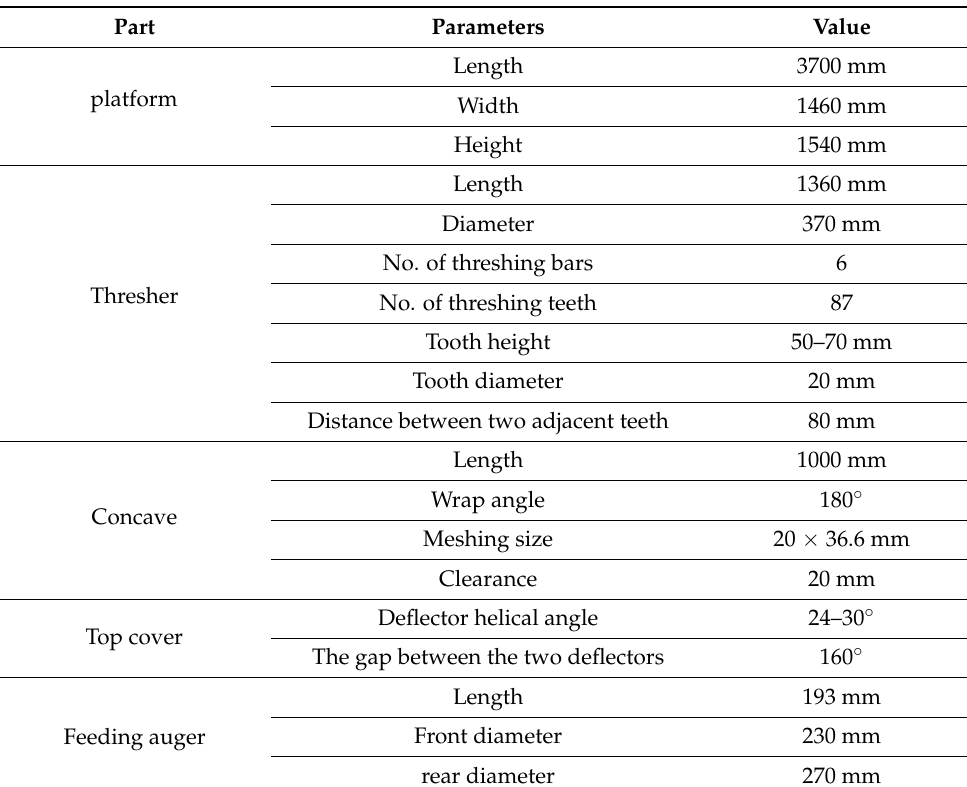
Figure 1. Testing platform. Table 1. Characteristics of the platform. Table 1. Characteristics of the